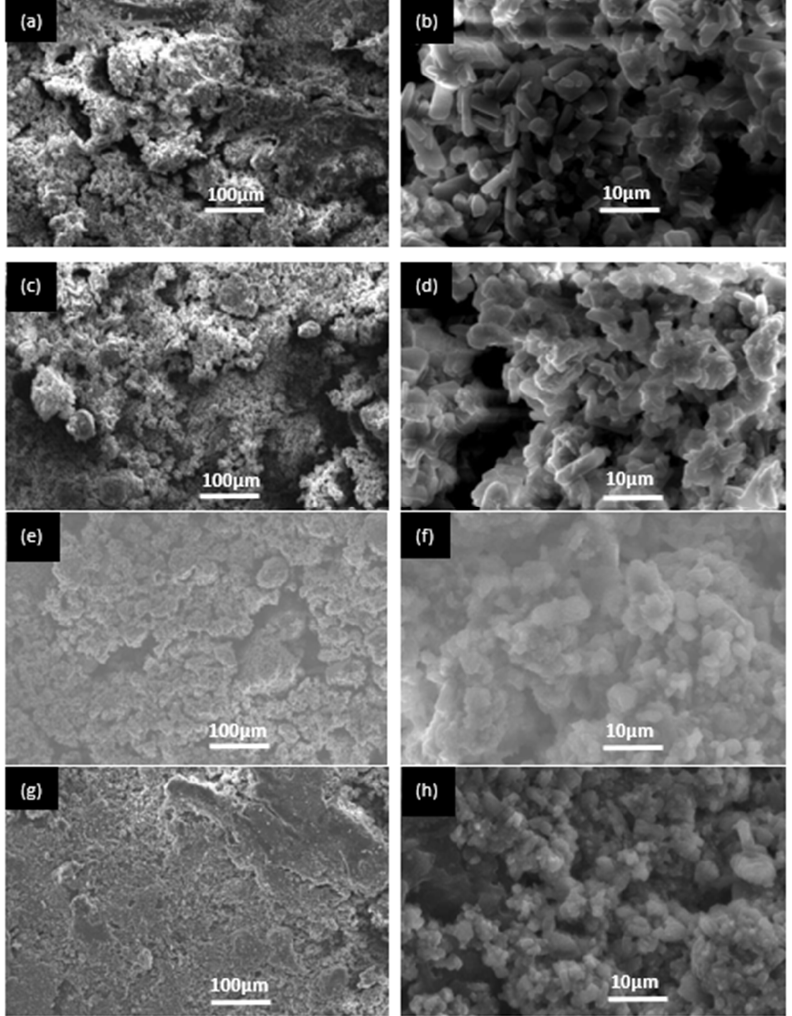
Figure 2. SEM images of BMPC samples. ( a , b ) BMPC0; ( c , d ) BMPC20; ( e , f ) BMPC40; ( g , h ) BMPC60.